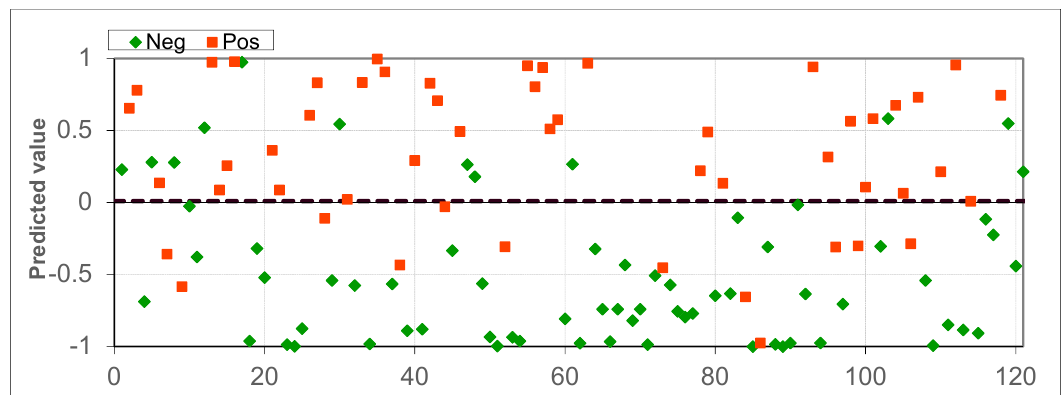
Figure 2. Scatter plot for all healthy patients, patients with laryngeal or oropharyngeal cancer, and patients with lung cancer.